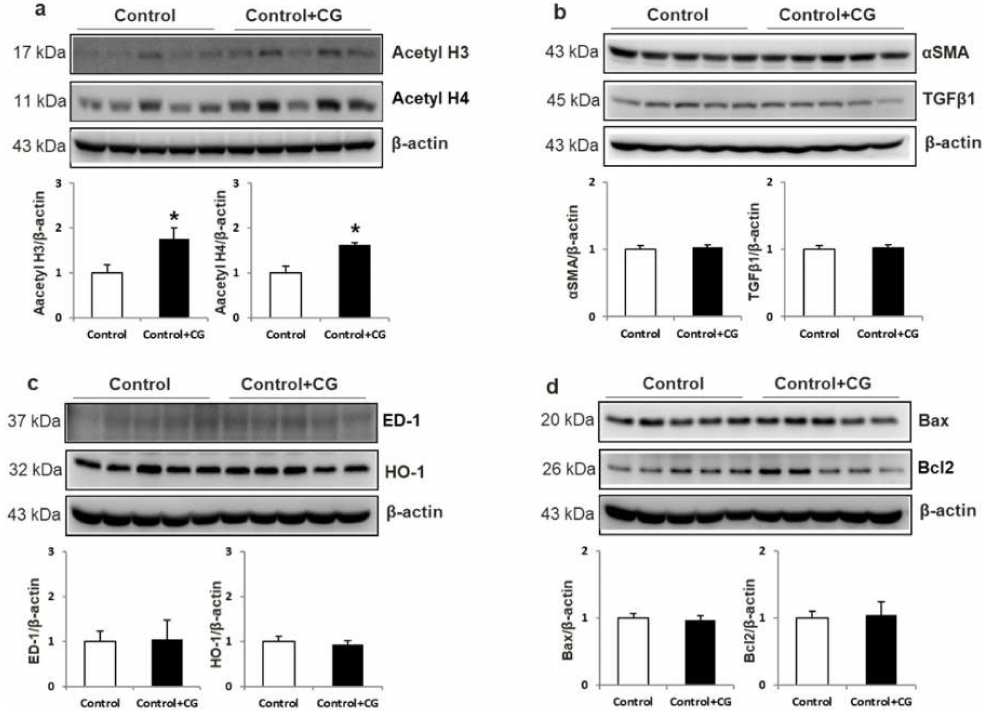
Figure 8. Toxicity of GC200745 (CG) to control rats. Semiquantitative immunoblotting of acetyl H3 and acetyl H4 in the kidney. Densitometric analysis revealed that the protein expression of acetyl H3 and acetyl H4 was increased in the CG-treated control group compared to that in controls ( a ). α -SMA and TGF- β ( b ), ED-1 and HO-1 ( c ), and Bax and Bcl2 ( d ) expression levels were not different between control and control + CG groups. * p < 0.05, when control + CG groups were compared to control group.